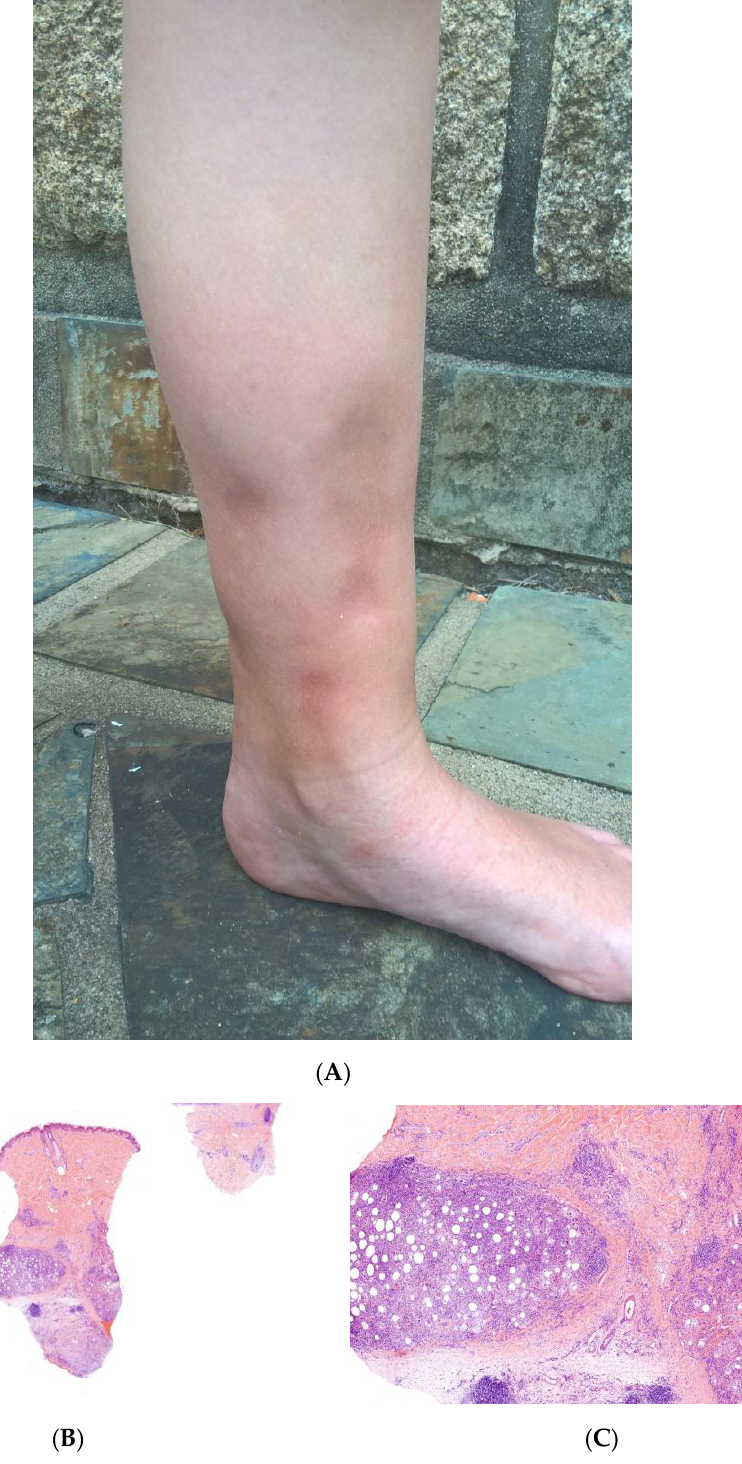
Figure 5. A Recurrent lipoatrophic panniculitis of children. ( A ) Areas of lipoatrophy in the leg Photo Dermatology Department Hopital Necker Enfants Malades. Paris France . ( B , C ) Lobular panniculitis with a mixed infiltrate, including neutrophils, as well as lymphocytes and macrophages. ( B ) Original Venerologie und Allergologie Göttingen